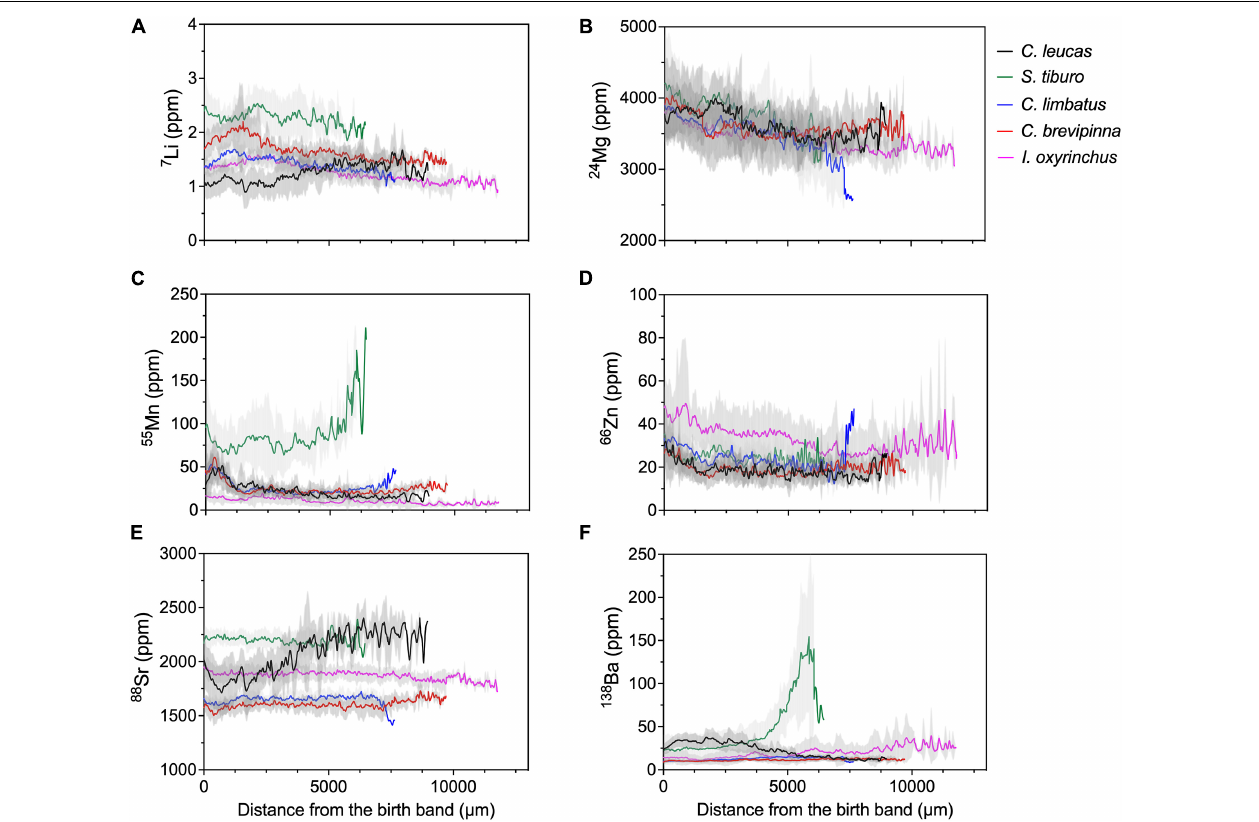
FIGURE 3 | LA-ICP-MS transects for each individual element, with species represented by color. Solid lines represent the mean value of the element from the birth band (distance = 0) to capture for each species individually. Shaded areas represent 95% confidence intervals around the